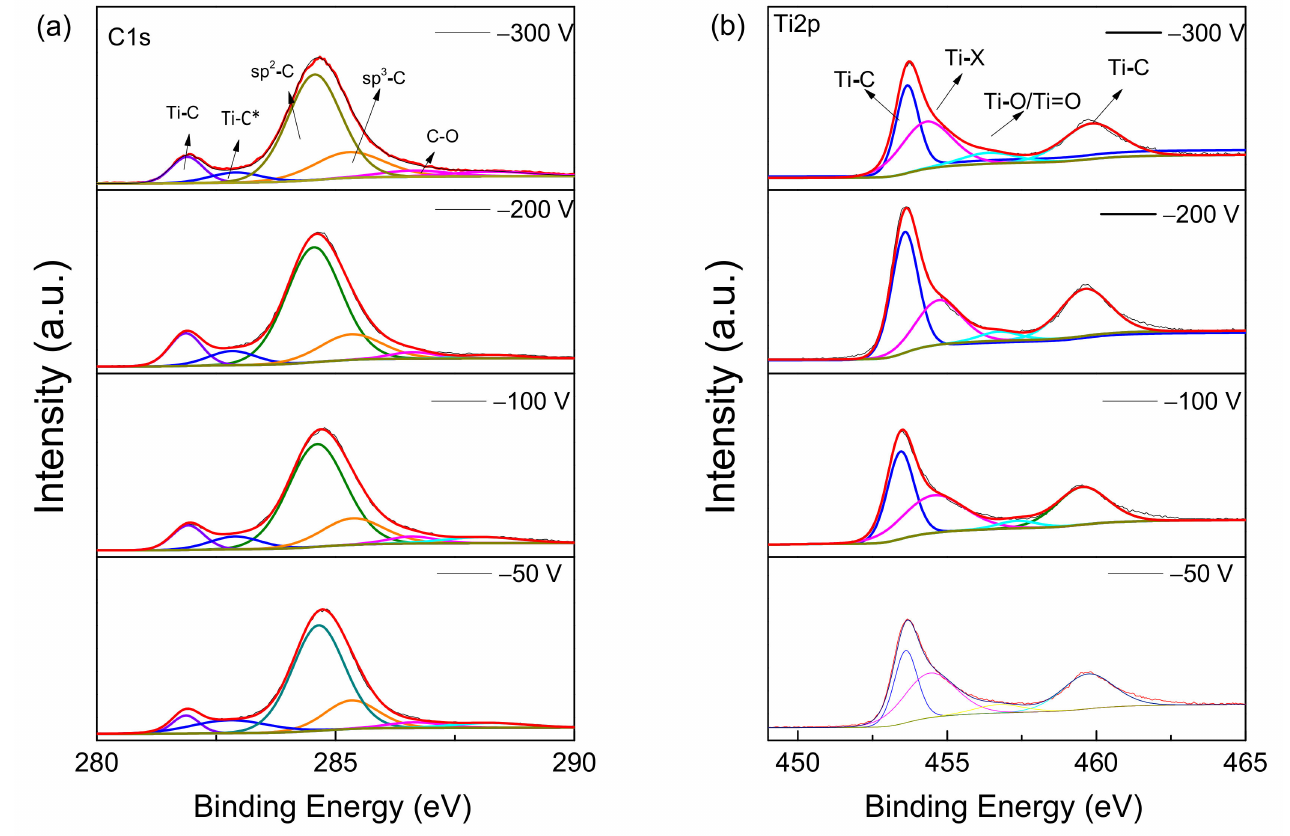
Figure 5. The C 1s ( a ) and Ti 2p ( b ) spectra of Ti-DLC coatings at varied bias voltage. The adhesion strength test of Ti-DLC coatings was carried out using a Rockwell indenter HR-150. The SEM micrograph indentation morphologies of Ti-DLC coatings deposited under different bias voltages after Rockwell tests are demonstrated in Figure 7. All coatings show great adhesion of above HF1, and no radial cracks or delamination appear at the indentation boundary. The excellent adhesion strength between the substrate and coating can be ascribed to presence of the transition Ti